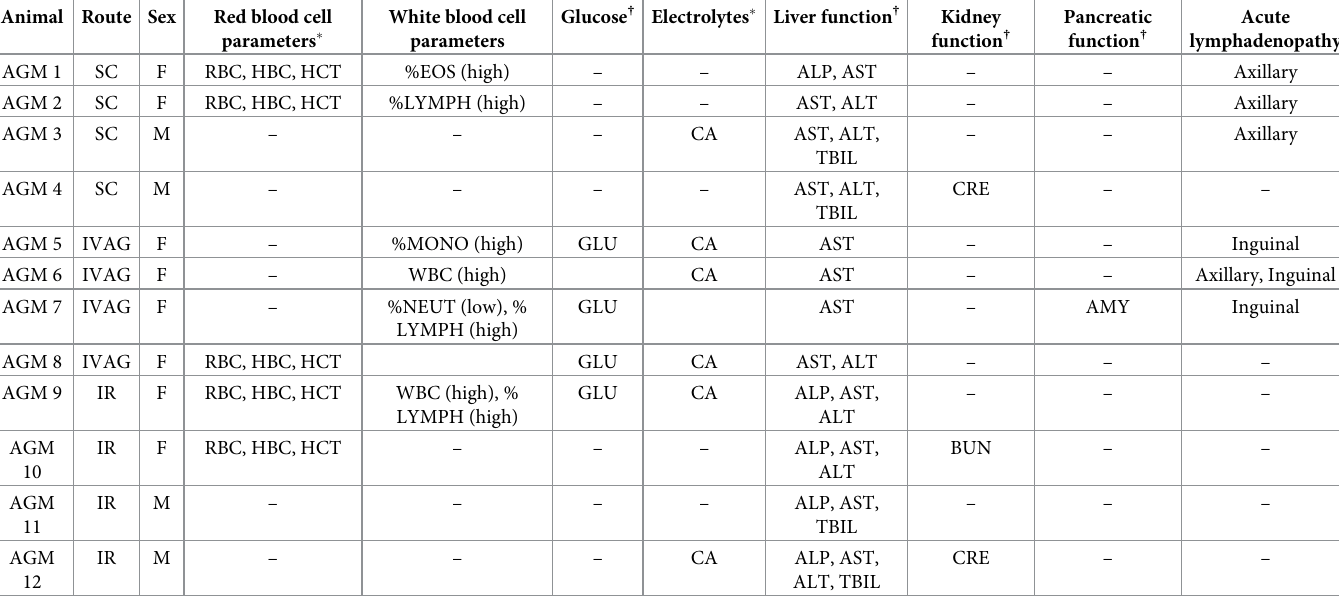
Table 4. Abnormal laboratory results and clinical observations, days 1 to 15 post-inoculation. Animal Route